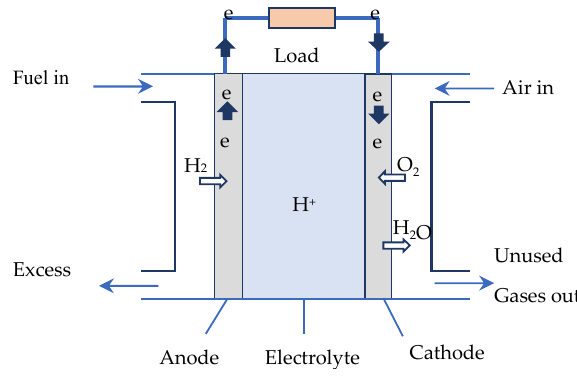
Figure 1. Schematic diagram of a PEMFC.